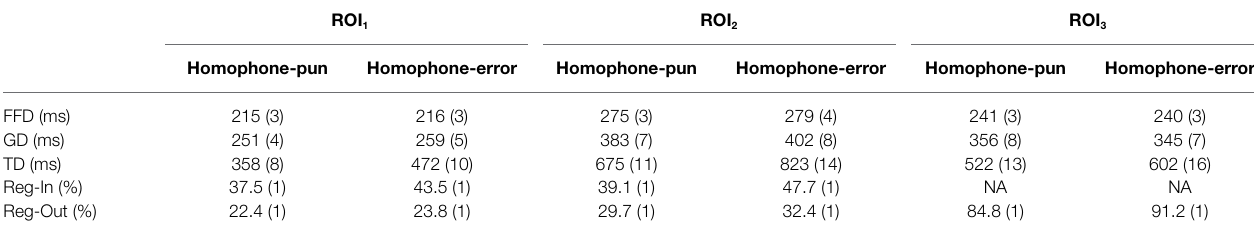
TABLE 4 | Fixation data of different ROIs in homophone-pun and homophone-error